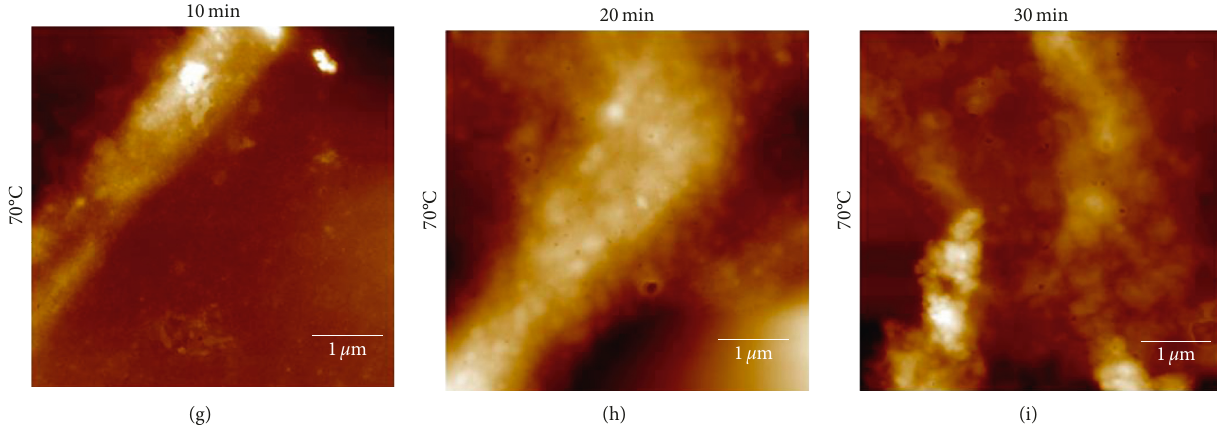
Figure 6: Typical AFM height images of collagen fibers heated in a water bath at (a–c) 50 ° C, (d–f) 60 ° C, and (g–i) 70 ° C for 10, 20, and 30min, respectively.